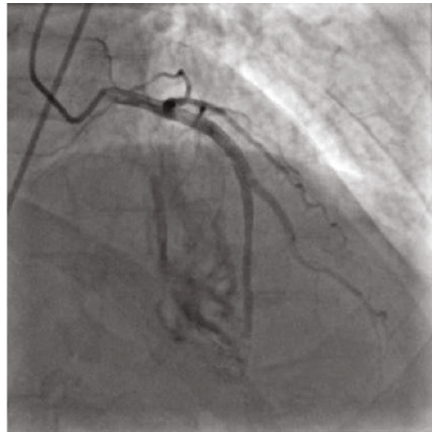
Figure 3: Angiography of the LAD demonstrating an iatrogenic LAD to RV fi stula.